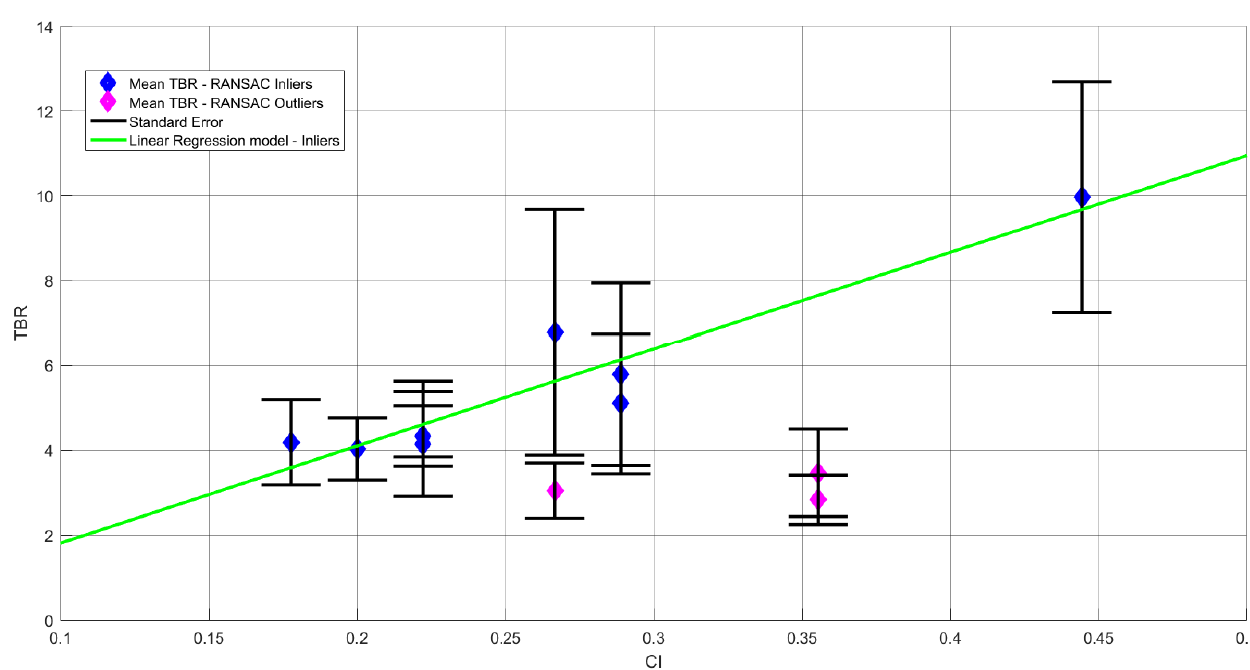
Figure 1. CI effect on TBR—regression model—channel F4.